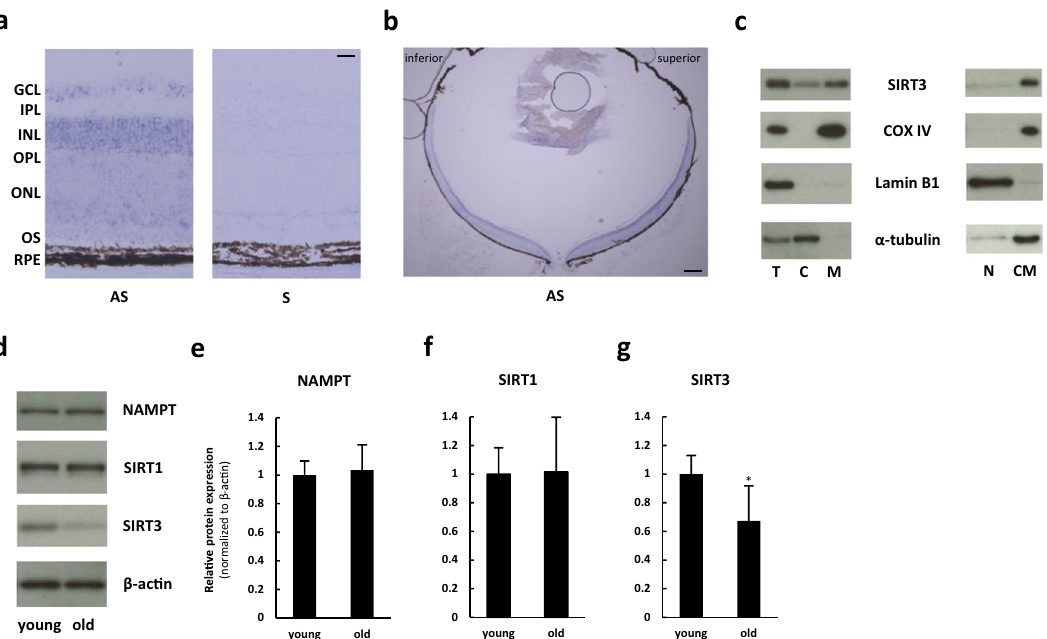
Fig. 1 Retinal SIRT3 was mainly expressed in mitochondria, and the level was decreased with age. a , b In situ hybridization of Sirt3 in the retina of 10-week-old C57BL6/J mice. Scale bars: a 20 μ m b 200 μ m. GCL ganglion cell layer, IPL inner plexiform layer, INL inner nuclear layer, OPL outer plexiform layer, ONL outer nuclear layer, OS outer segment, RPE retinal pigment epithelium, AS antisense, S sense. c Representative Immunoblot of SIRT3 for subcellular fraction of the retina of 10-week-old C57BL6/J mice. T total retina, C cytoplasmic, M mitochondrial, N nuclear, CM cytoplasmic and mitochondrial fractions. d – g Immunoblot of young (10 weeks old) and old (60 weeks old) C57BL6/J mice retina against nicotinamide phosphoribosyltransferase (NAMPT) e , SIRT1 f , and SIRT3 g ( n = 5 for each group). * p < 0.05 by two-tailed unpaired t -test. Values are mean ±